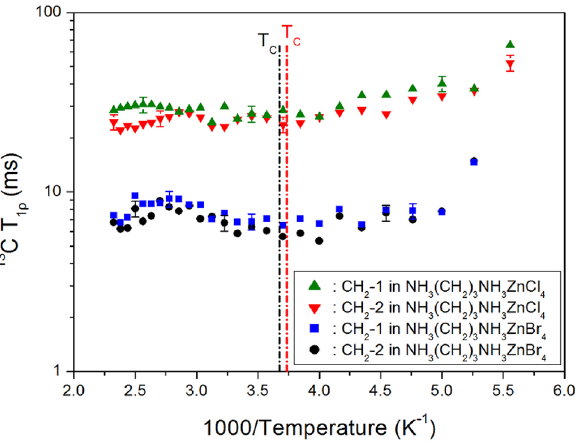
Figure 8. T 1ρ for CH 2 -1 and CH 2 -2 of [NH 3 (CH 2 ) 3 NH 3 ]ZnCl 4 and [NH 3 (CH 2 ) 3 NH 3 ]ZnBr 4 as a function of inverse temperature.